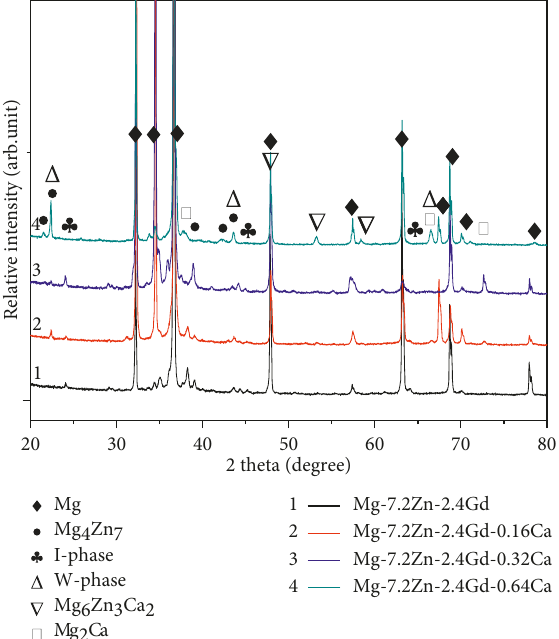
Figure 2: XRD result of the as-cast Mg-Zn-Gd(-Ca)